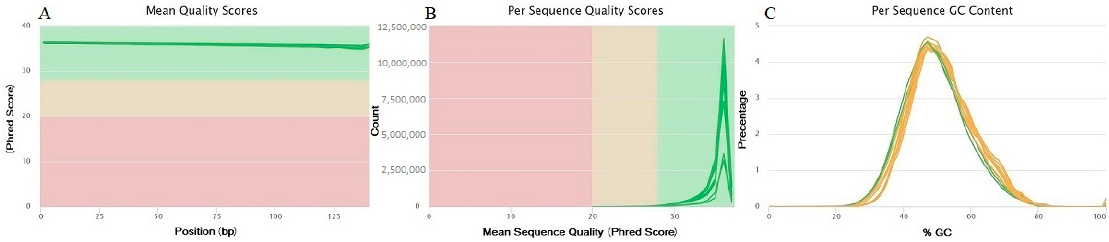
Figure 2. The quality assessment results for the trimmed RNA-Seq data. ( A ) Mean quality scores. ( B ) Per sequence quality scores. ( C ) Distribution of GC content.